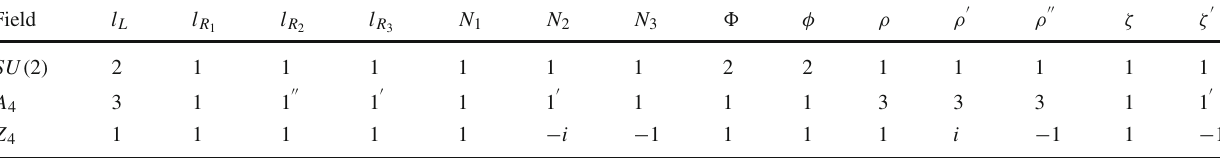
Table 1 Fields and their respective transformations under the symmetry group of the model